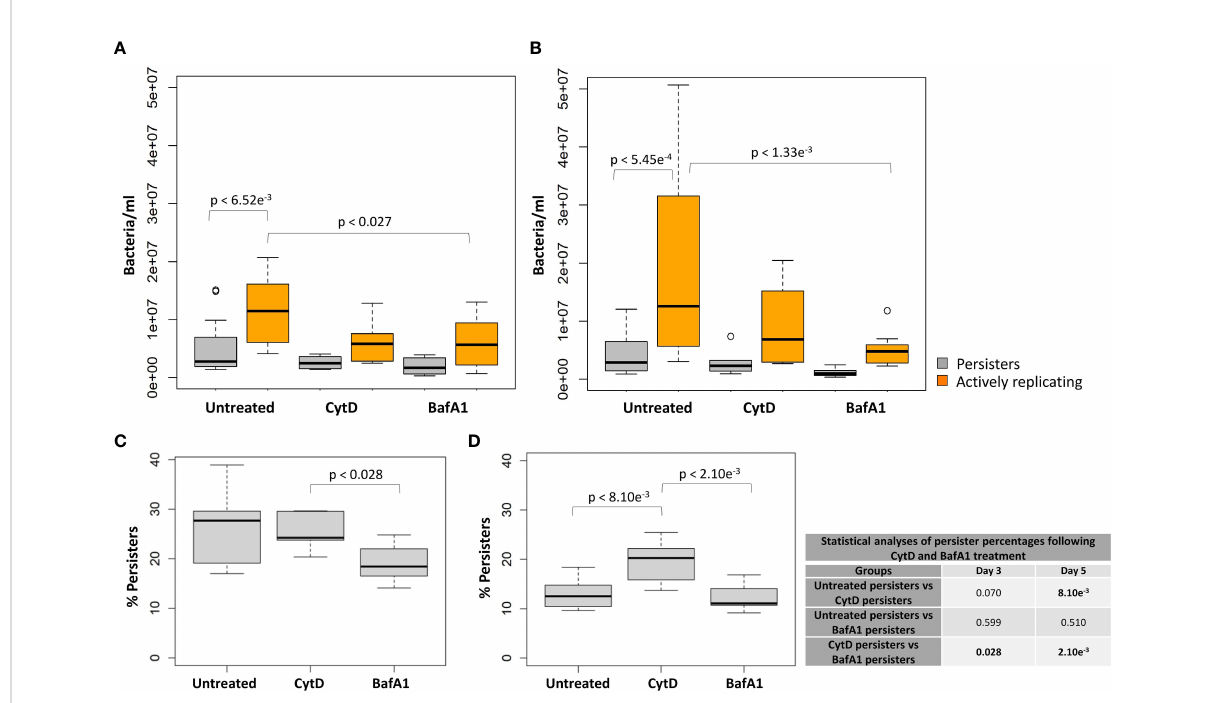
FIGURE 7 Macrophage antimicrobial processes impact M. tuberculosis persister formation. The persister subpopulation was visually assessed using fl ow cytometry at day 3 and day 5. Signi fi cant differences between groups was observed at (A) day 3 (p = 0.006) and (B) day 5 (p = 0.034; repeated measures ANOVA). p-values are listed in Table 3. The median percentage of persisters in relation to the respective intracellular bacterial numbers was assessed at (C) day 3 and (D) day 5. Signi fi cance testing between persister percentages was assessed using a pairwise Students t-test (unpaired) with Bonferroni correction; signi fi cant p-values (p < 0.05) are shown in bold. Box and whisker plots express distribution of data independently conducted in 4 biological experiments, including technical triplicates, indicating the median (bold line), interquartile range (box), and range (whiskers).